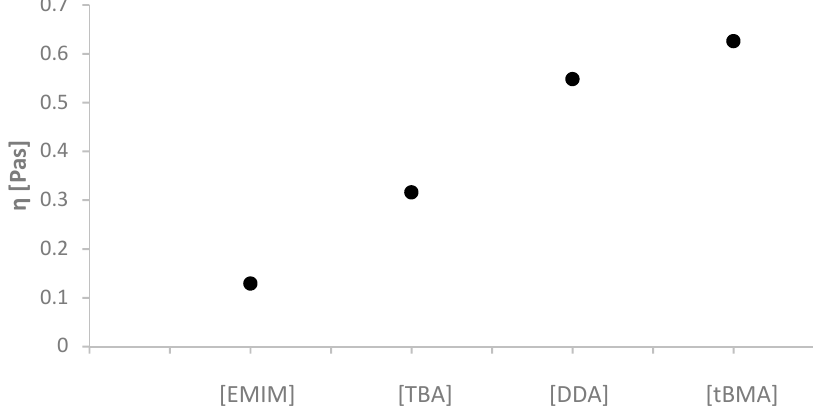
Figure 5. Effect of cation type on the viscosity, η , for threonine-based ionic liquids.